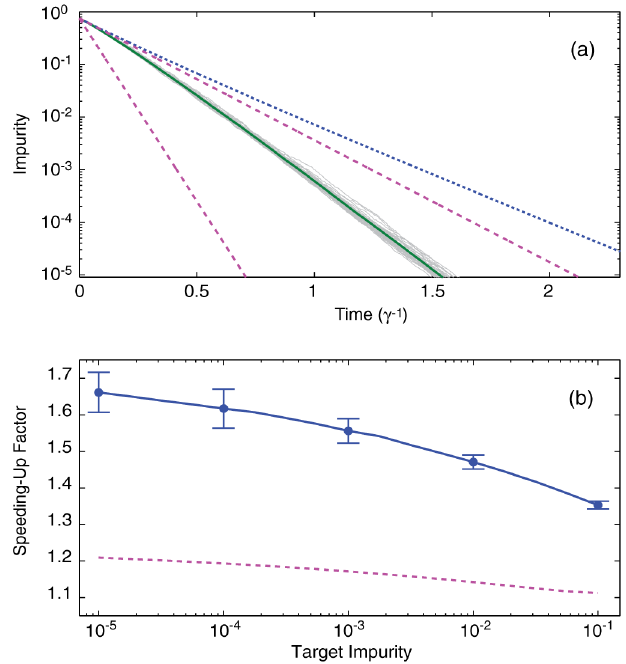
FIG. 15. (a) Impurity for a two-qubit register. The small- dashed blue line indicates a continuous measurement; the solid green line, the average impurity for feedback; the solid gray lines, individual trajectories; the dashed magenta lines, the upper [Eq. (43)] and lower [Eq. (44)] bounds, respectively. (b) Speeding-up is indicated by the solid blue line, and the lower bound by the dashed magenta line. The upper bound is not shown, as it is well above the numerical result. The ensemble size is 20, and feedback was applied at times (cid:7)t ¼ 1 (cid:8) 10 (cid:2) 3 (cid:2) (cid:2) 1